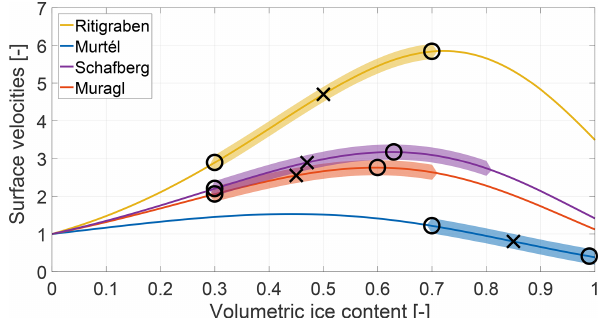
Figure 3. Normalised surface velocities for the four case studies with volumetric ice content values. For each rock glacier the veloci- ties are normalised with the velocity value corresponding to 0% ice content. The coloured buffer around the curve shows the range pro- posed by the literature (Vonder Mühll, 1993; Arenson et al., 2002; Lugon and Stoffel, 2010). The black circles show for each curve the maximum and the minimum possible velocity values within this range, also representing the uncertainty range for the modelling. The black cross shows the chosen volumetric ice content value for the modelling, i.e. the middle value of the latter